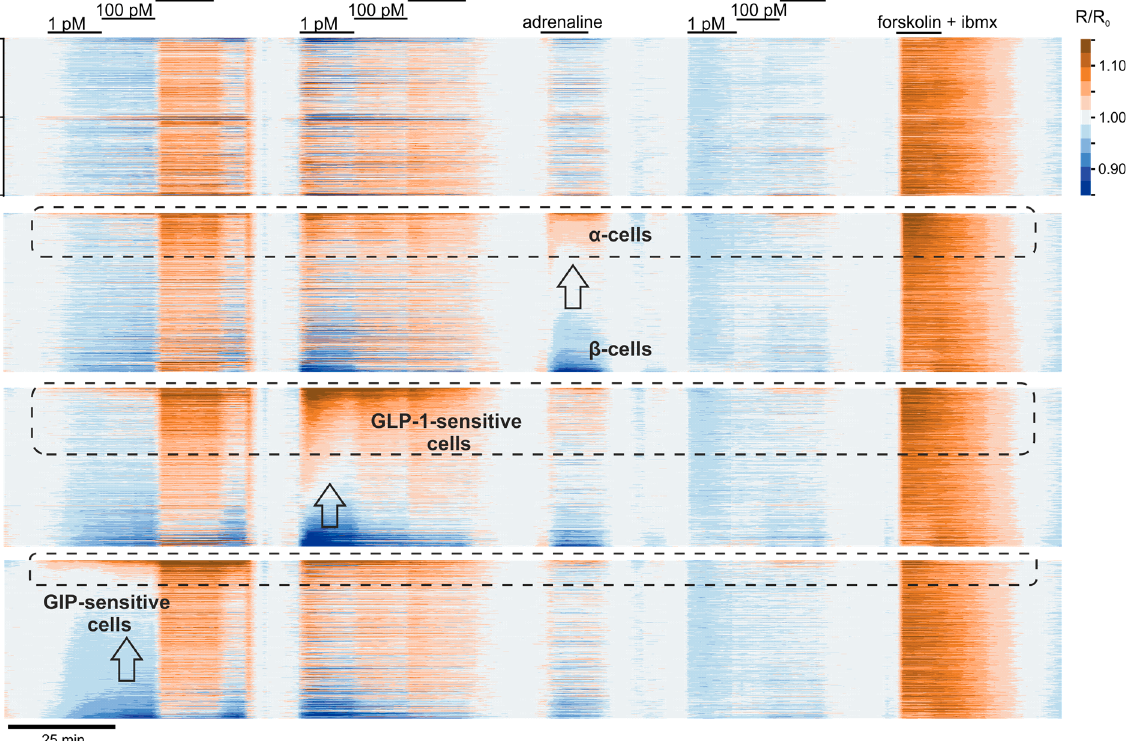
Figure 3. Identification of cell populations based on pharmacology. ( a ): Baseline-corrected data presented as a heat map to reflect the behavior of individual cells in response to various agonists, as indicated. ( b ): the same data but ranked according to the response to adrenaline, a marker compound for α -cells. ( c , d ): the same data sorted by the response to incretins GLP-1 (7–36) ( c ) and GIP ( d ).